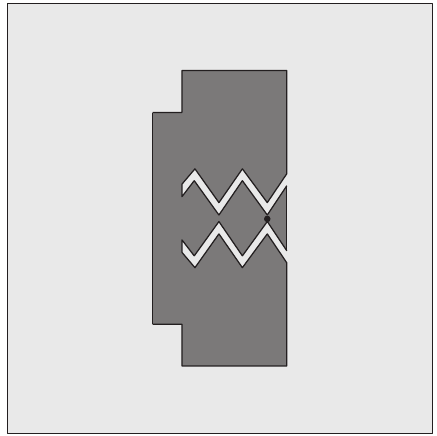
Figure 2: A compact perturbed E-shaped patch antenna [9]. Corner notches and zig-zag slots realized on the metallic patch are adopted to obtain a wideband behavior, while a 50 Ω probe is inserted between the first teeth of the zig-zag slots to excite the antenna. Dark gray monopole and light gray dielectric